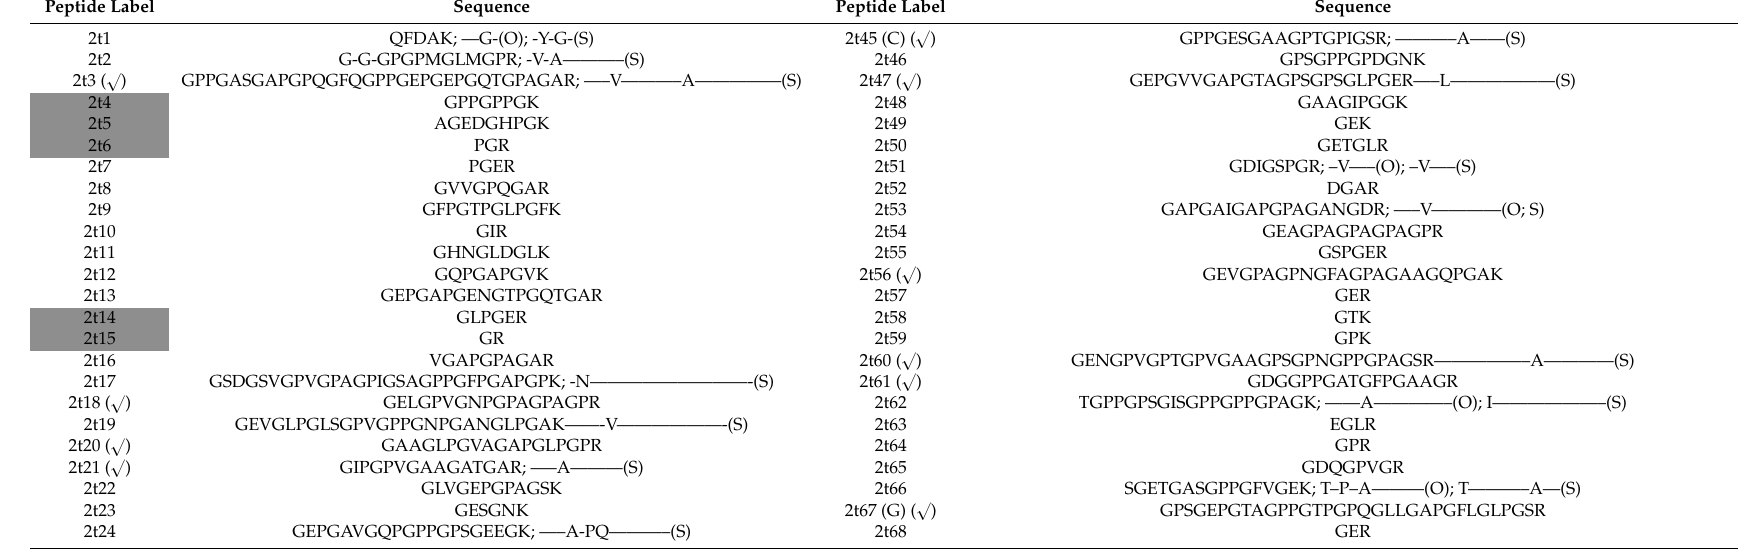
Table 2. COL1A2 peptide sequences showing amino acid variations between artiodactyl taxa (hyphen indicates identical amino acid residue as the main ‘ sequence = Bos ; sequences followed by O = Ovis and S = Sus ). ( ) indicates observation of precursor in (at least 2 of 3) fingerprints (PMF data); shaded cells indicate lack of observation in (at least 2 of 3) LC-based results (see Tables S1–S3); single lettering under “Peptide label” indicates PMF species biomarker from Buckley et al.